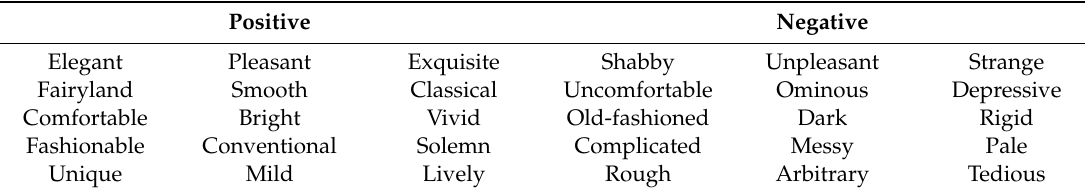
Table 6. The 30 Emotional Words.